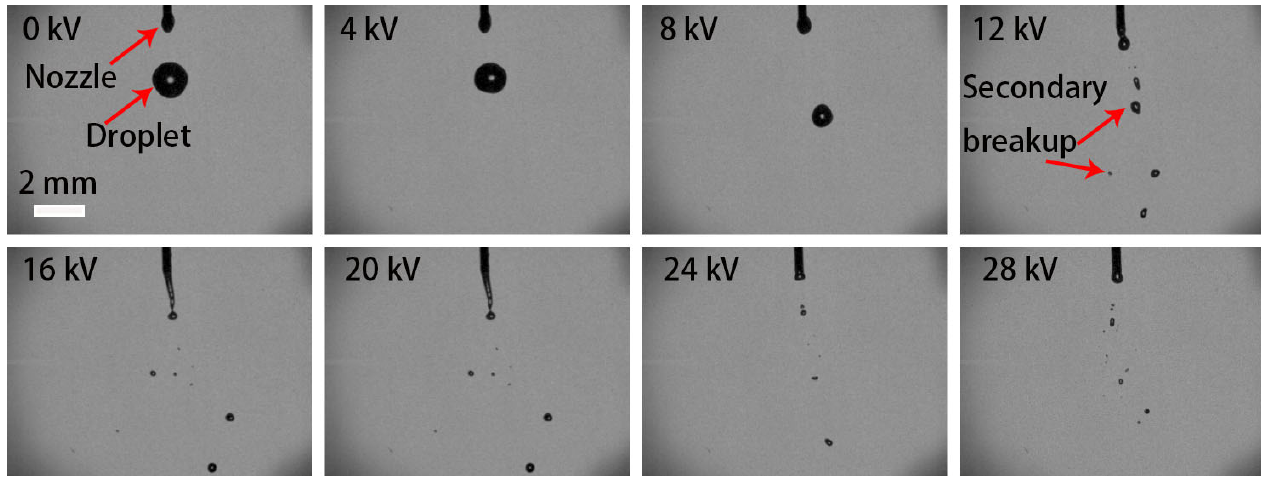
Figure 3. Pictures of electrostatic breakup of H 2 O 2 ligaments and droplet formation at different electric field voltages (21G nozzle, flow rate of 400 mL/h, 35 wt. % concentration).